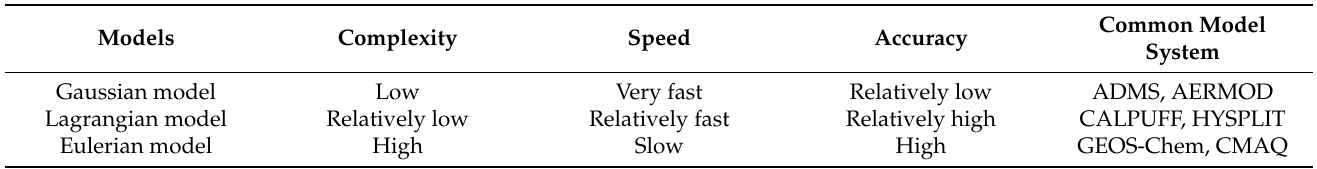
Table 1. Comparison of the three